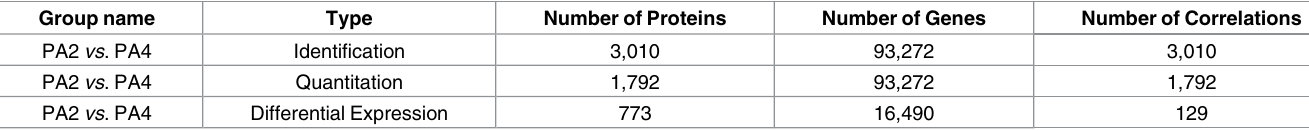
Table 2. Correlation analysis of transcription and